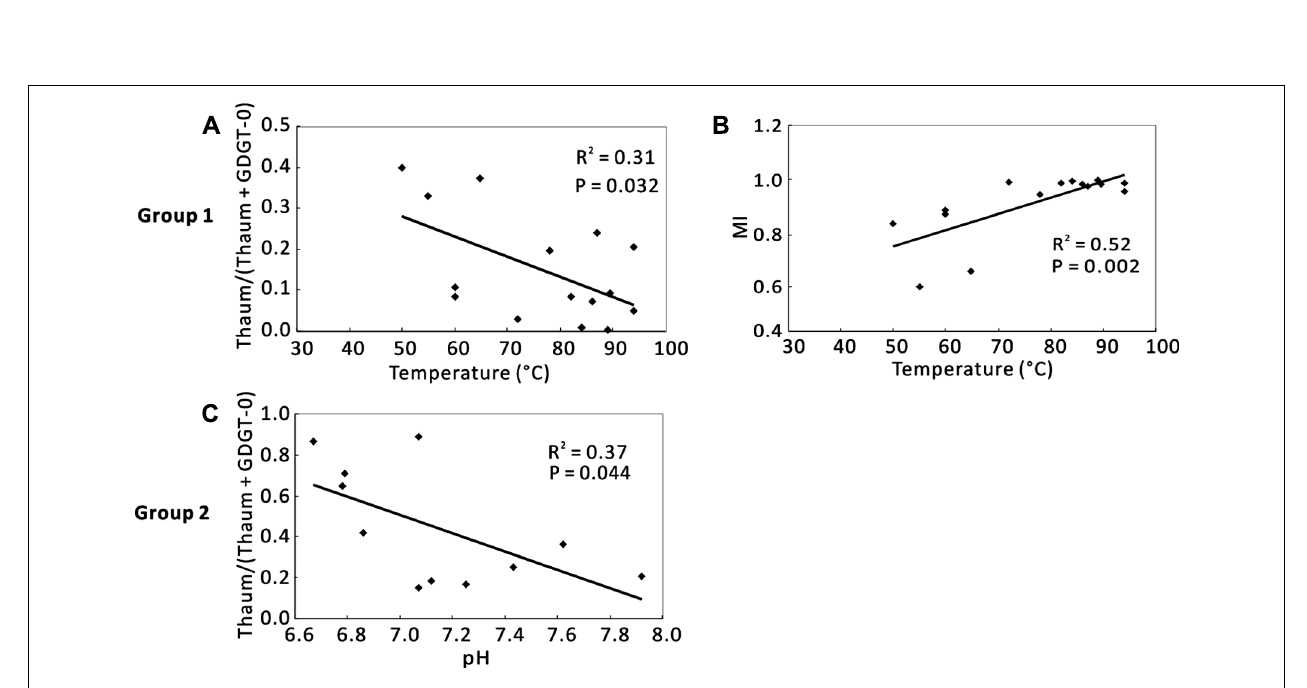
FIGURE 5 | Correlations between organic proxies and environmental parameters in two clustering groups according to Figure 3. (A) Thaum/ (Thaum + GDGT-0) and temperature in Group 1; (B) MI and temperature in Group 1; (C) Thaum/(Thaum + GDGT-0) and pH in Group 2.Thaum,Thaumarchaeol.